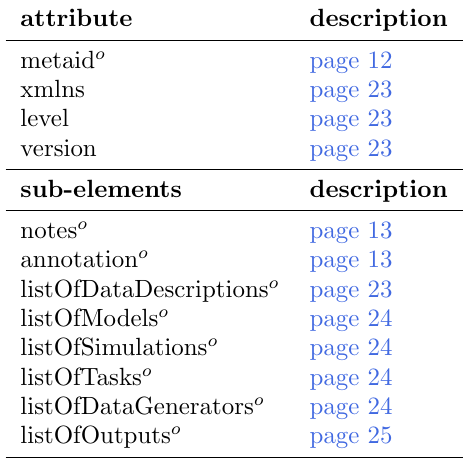
Table 2.5: Attributes and nested elements for SED-ML. o denotes optional elements and